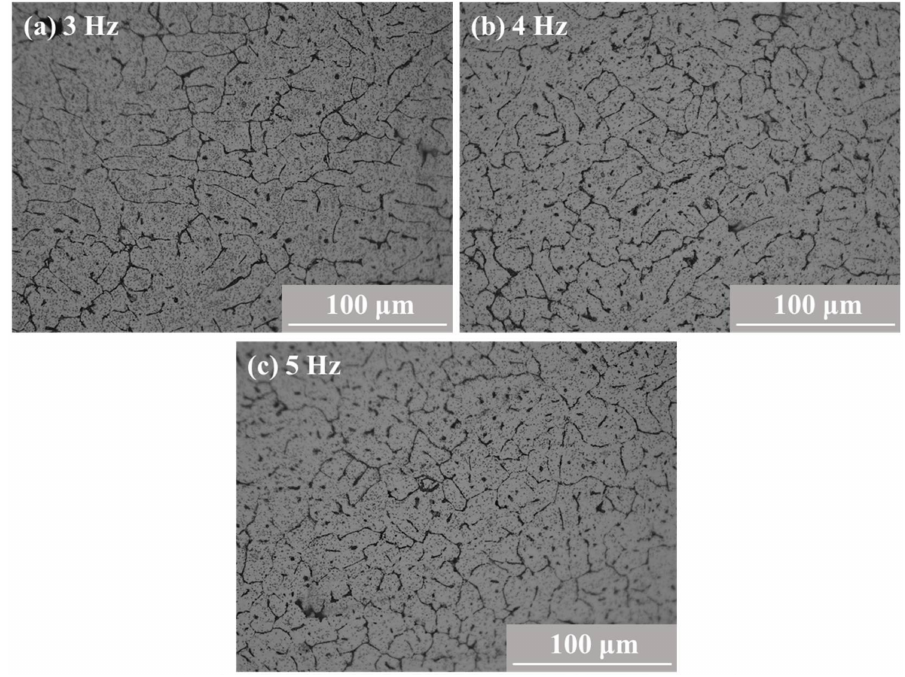
Figure 7. Microstructure photograph of fusion